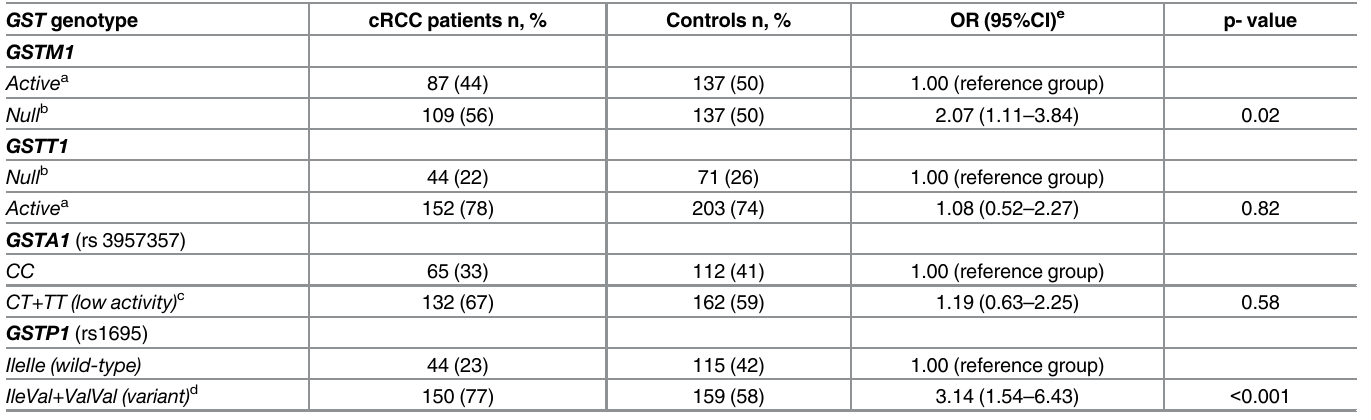
Table 3. GST genotypes in relation to the risk of